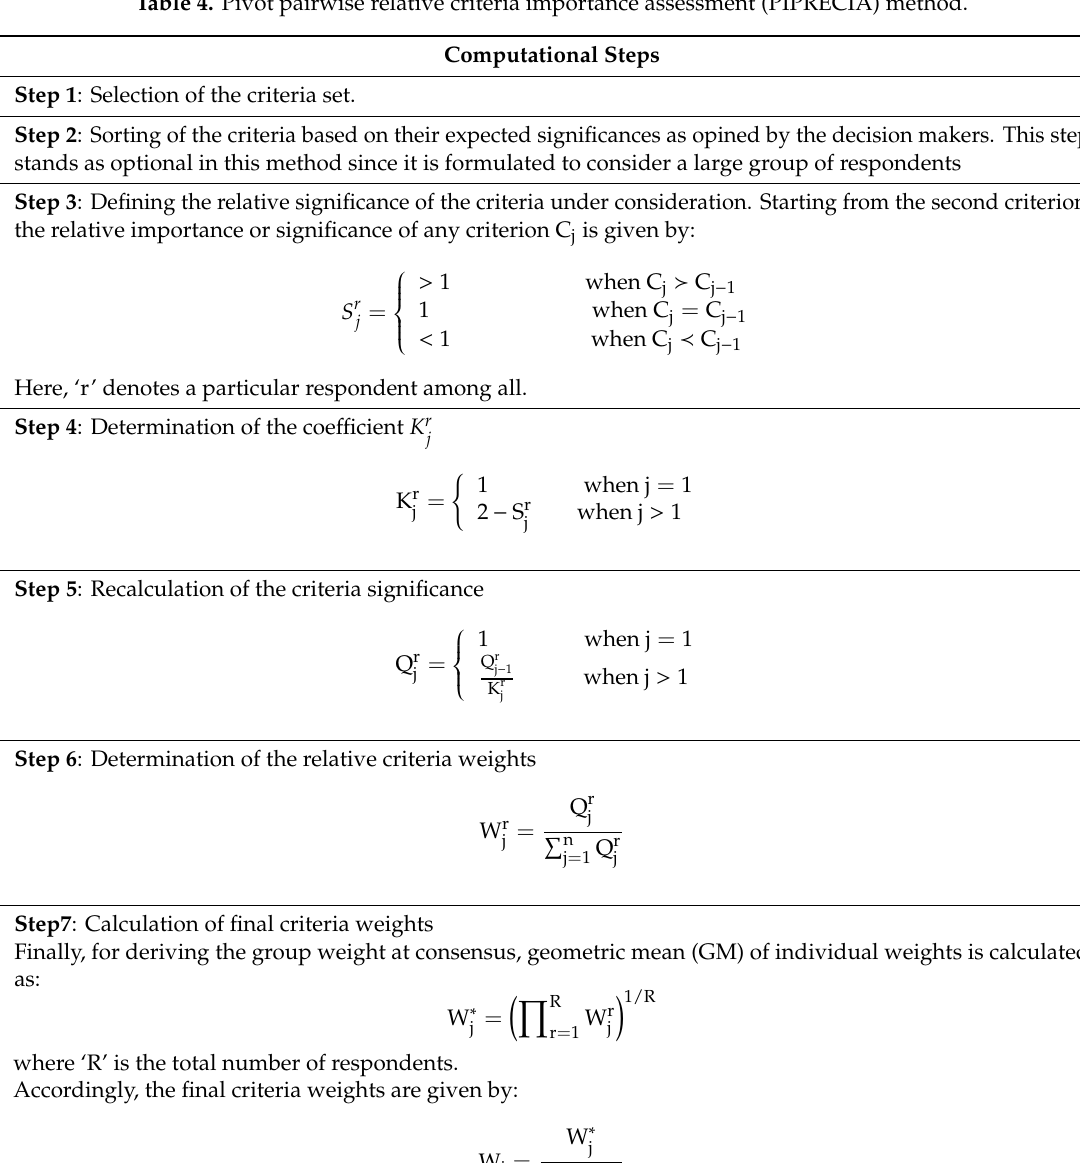
Table 4. Pivot pairwise relative criteria importance assessment (PIPRECIA)